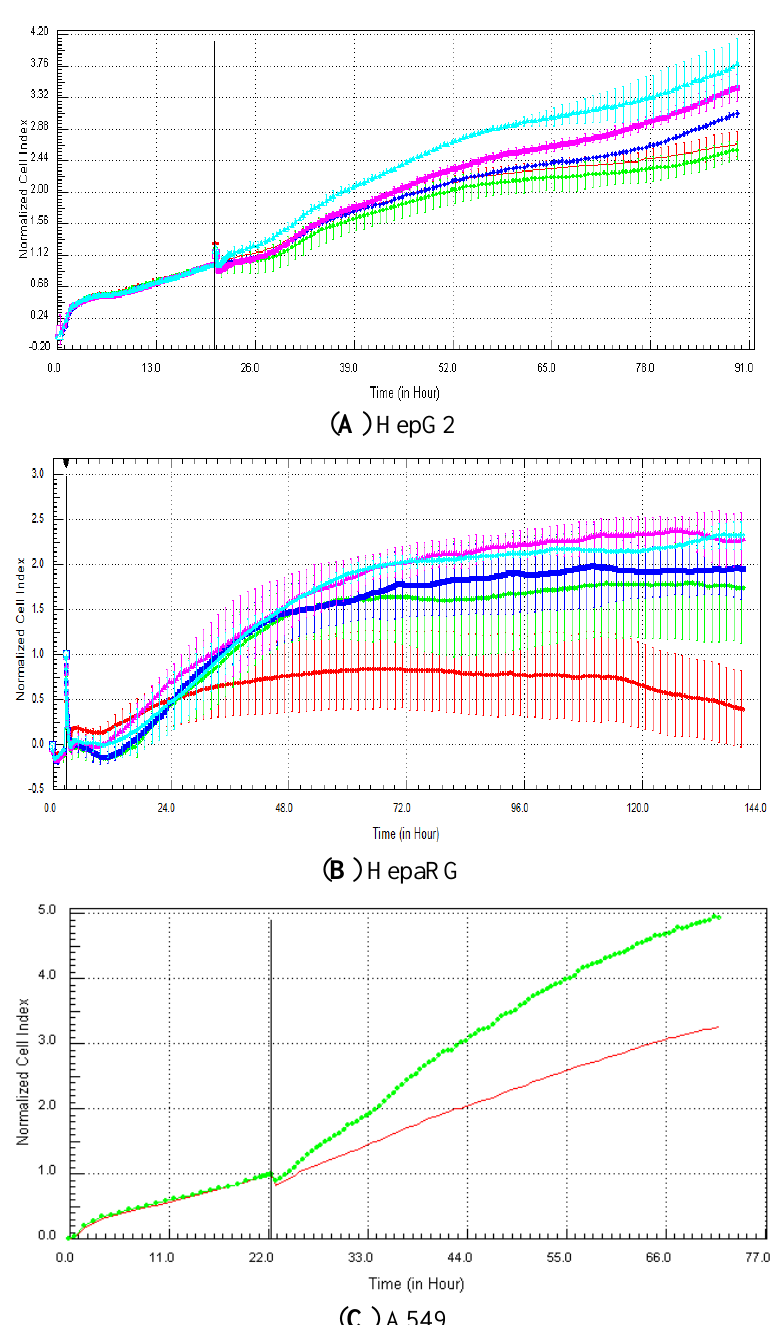
Figure 6. Effect of methylprednisolone (nuclear receptor modulator) on cell index curves (RTCA) in HepG2, fresh HepaRG and A549 cells. HepG2 ( A ) and HepaRG ( B ) cells were exposed for at least 72 h to 0 (0.5% DMSO, red curve), 0.1 (green curve), 1 (dark blue curve), 10 (purple curve) and 100 (light blue curve) µM and A549 cells to 0 (control DMSO, red curve) and 20 µM (green curve) of methylprednisolone ( C from Abassi et al ., [9]). Cell indexes were normalized with the last time point before compound addition. Panels A and B: each data point was calculated from triplicate values (except for control cells n = 6). Data represent the average ± standard deviation (except for panel C). The normalized time point is indicated by the vertical line. For more details, please refer to the Materials and Methods